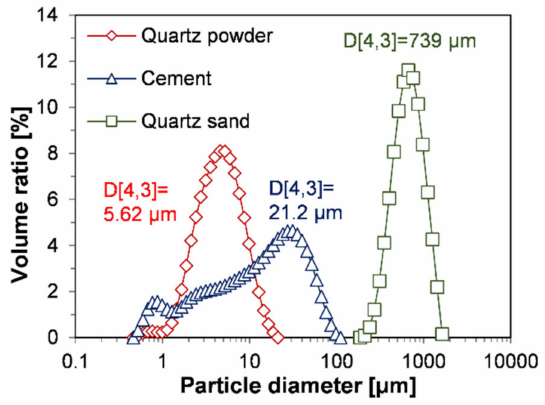
Figure 1. Particle size distribution of raw materials by laser di ff raction.